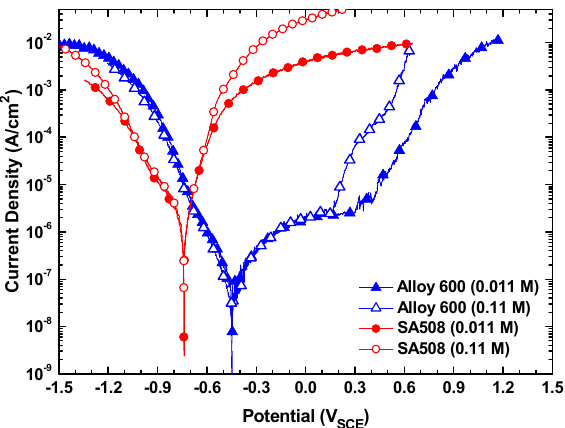
Figure 5. Polarization curves of Alloy 600 and SA508 in the 0.011 and 0.11 M solutions at a constant MRI 1.